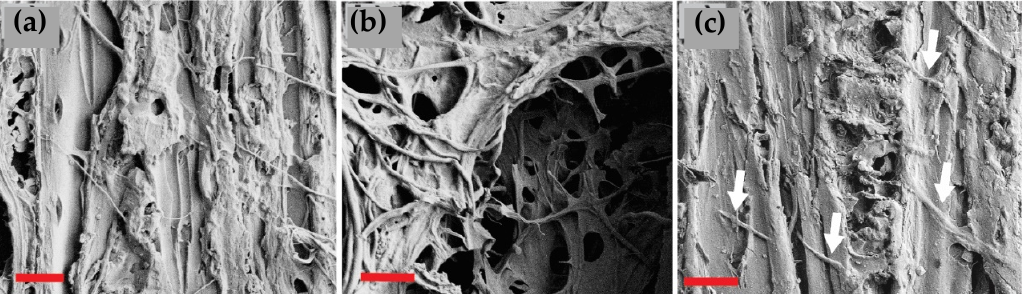
Figure 7. Surfaces of ( a ) BC-CP showing both thin hyphae of C. puteana and cell wall degradation visible as ragged structures; ( b ) abundant growth of C. puteana on BF–CP; ( c ) BF–TV imaged with arrows pointing to hyphae of T. versicolor . Imaged at 1000× magnification, bar = 10 µm.